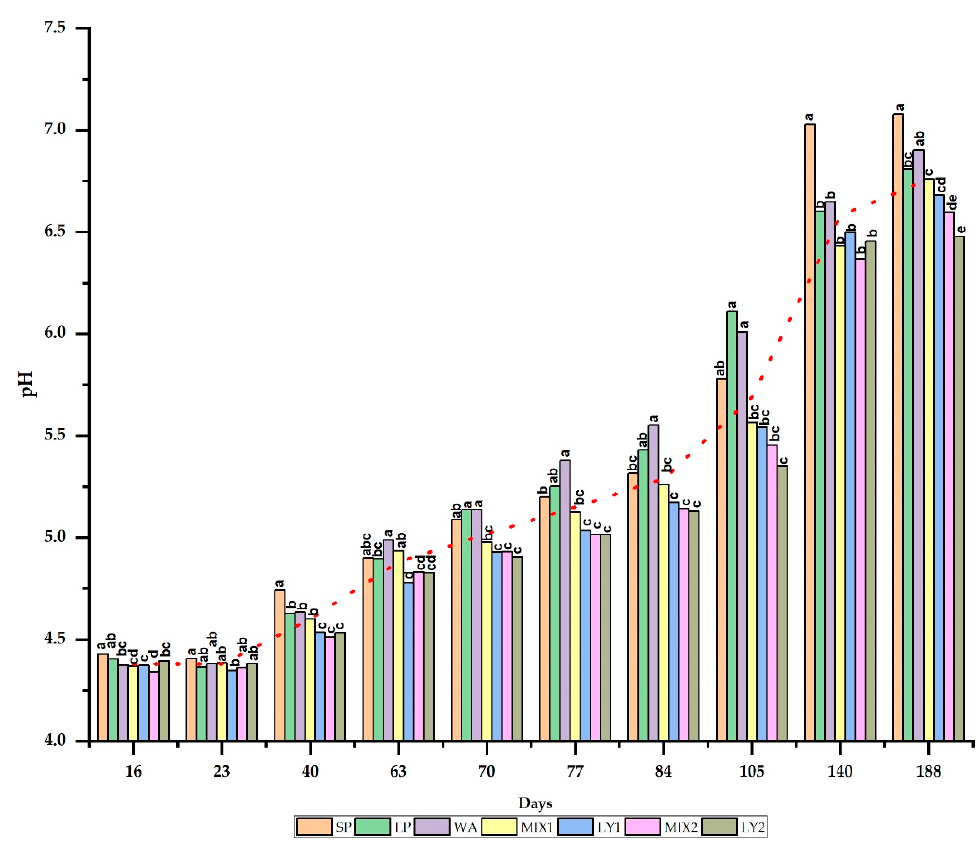
Figure 5. Brine pH values during fermentation. The data are expressed as averages of the triplicate measurements. Significant differences (LSD) are indicated by different letters ( p ≤ 0.05). The red dotted line represents the average pH values at each sampling time.